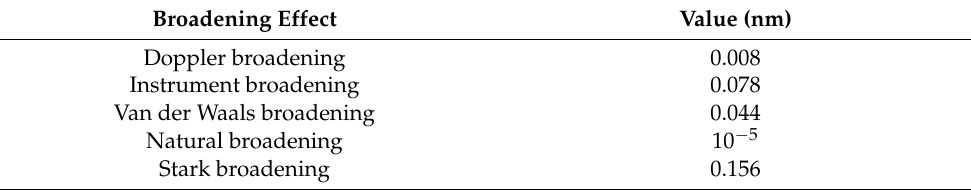
Liquid surface Figure 7. The spatial distributions of N 2 (C 3 Π u → B 3 Π g ), N + 2 (B 2 Σ → X 2 Π), OH (A 2 Σ → X 2 Π), O (3p 5 P → 3s 5 S 0 ) and He (3s 3 S → 2p 3 P 0 ) emission intensities.